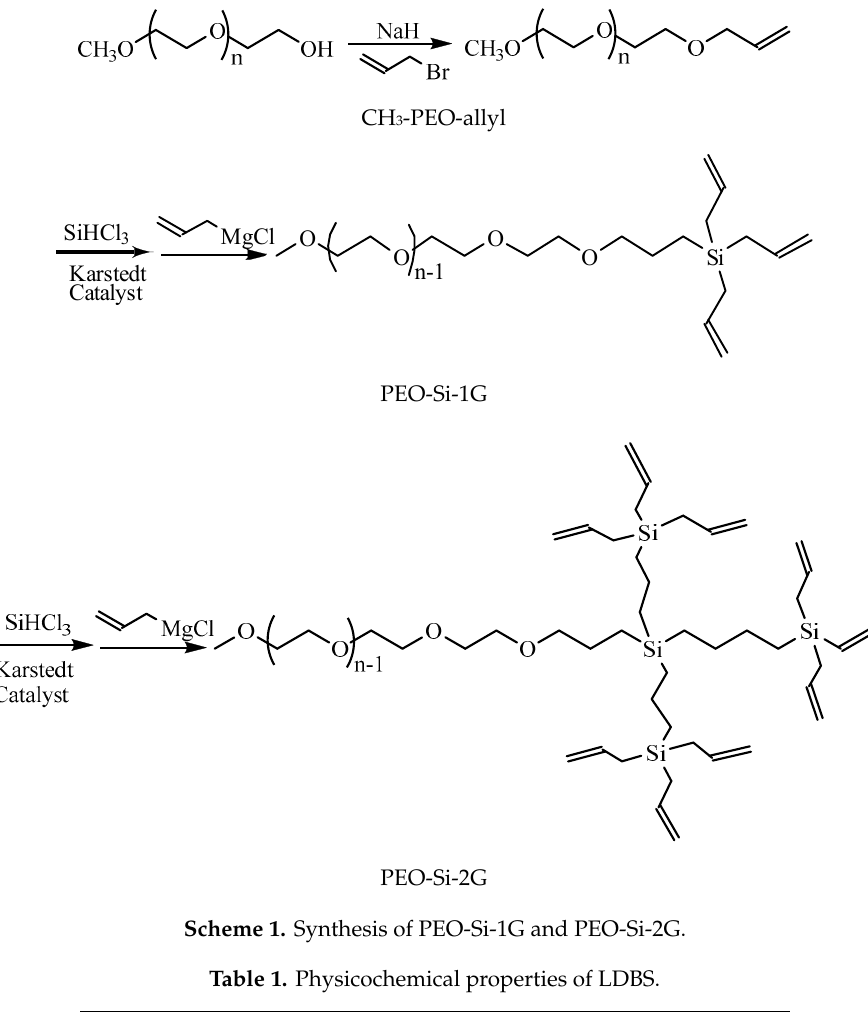
Scheme 1. Synthesis of PEO-Si-1G and PEO-Si-2G. Table 1. Physicochemical properties of